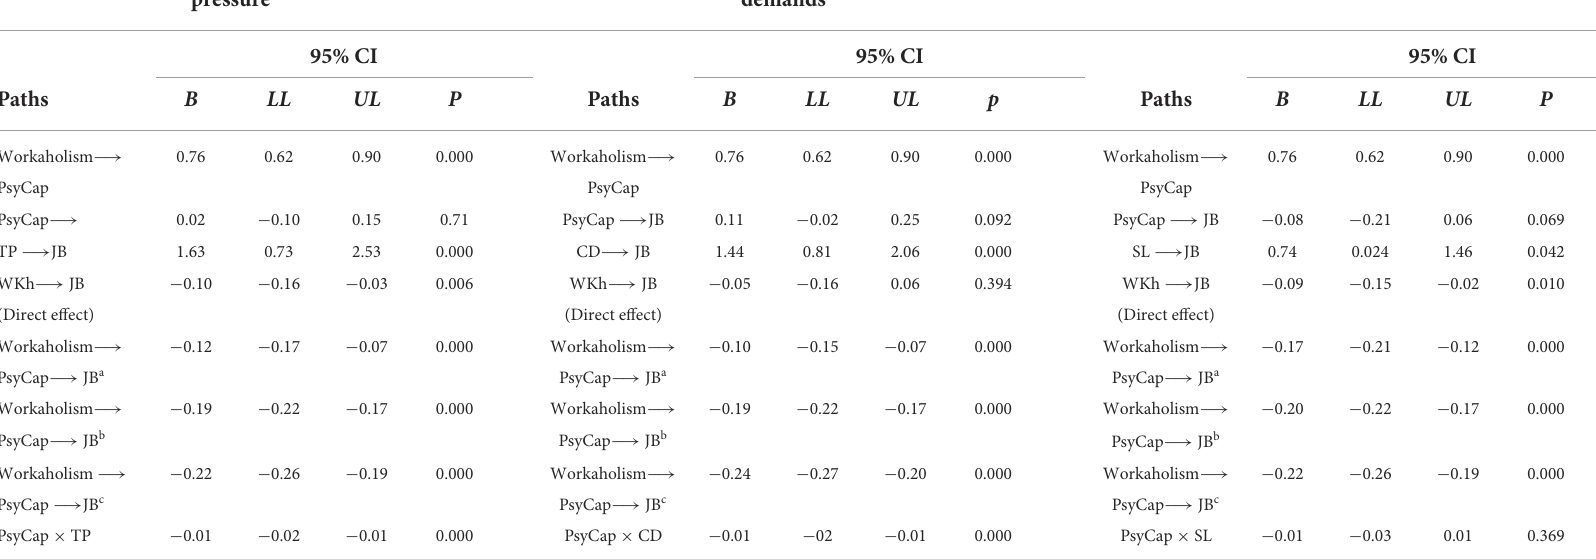
TABLE 3 Relationship of workaholism and job burnout mediated by PsyCap and moderated by time pressure, cognitive demands and social load ( N =